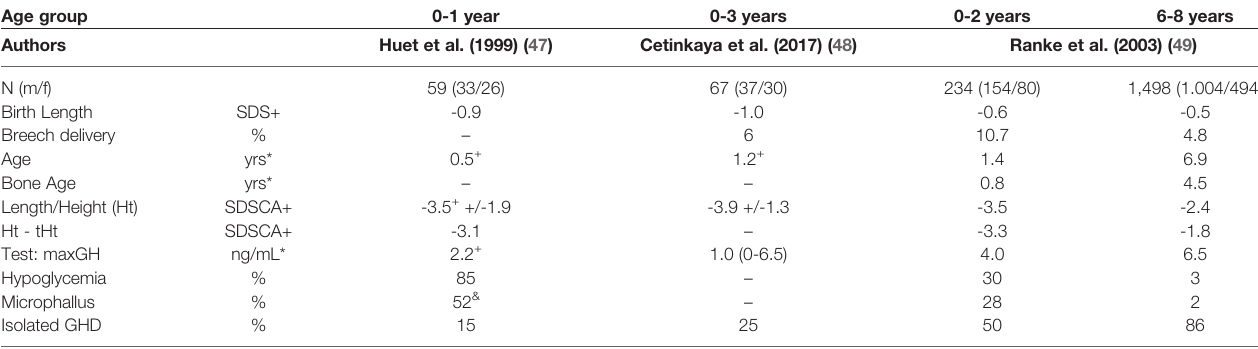
TABLE 1 | Characteristics of very early onset of GHD compared to childhood